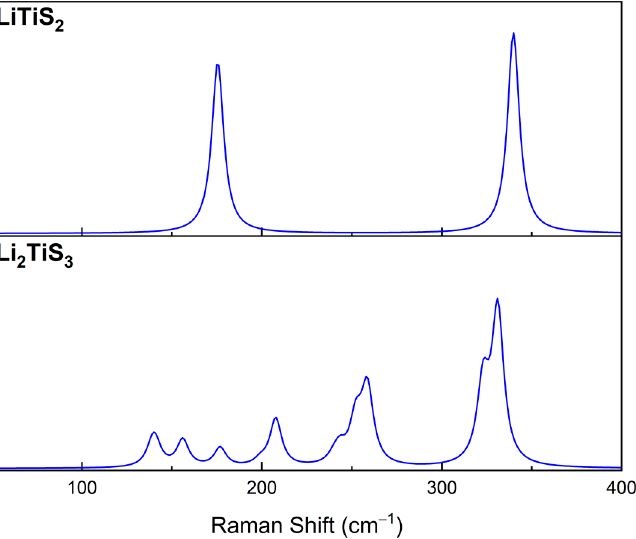
Figure 2. Raman spectra for LiTiS 2 and Li 2 TiS 3 computed with the B3LYP functional and basis set B .